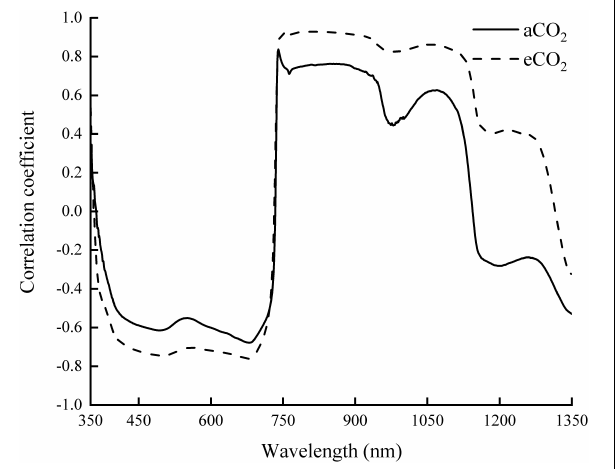
FIGURE 4 | The correlations between the chlorophyll content and the spectral reflectance of winter wheat during the whole growing season.